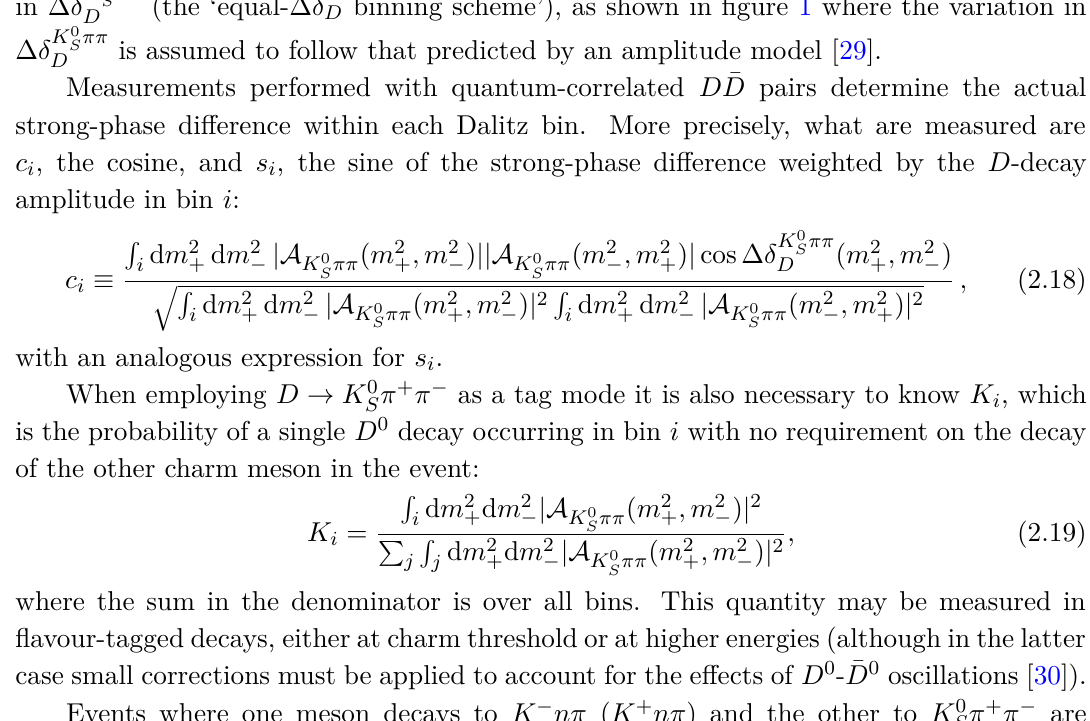
between symmetric points in the Dalitz plot is given by ∆ δ K 0 S ππ K 0 ππ ( m 2 ) . The bin boundaries are chosen such that each bin spans an equal range δ , m 2 S − + D in ∆ δ K 0 S ππ